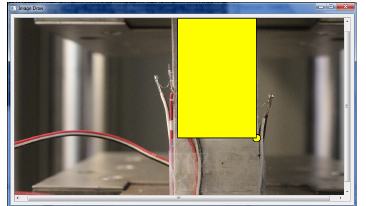
Figure 9: In yellow the selected area for vertical dispalcements.